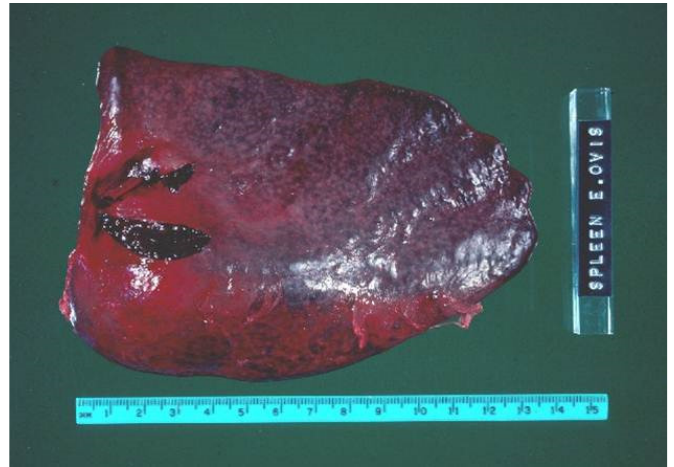
Figure 1. Historical image of splenomegaly in a lamb diagnosed with Epyrethrozoan ovis, now Myco- plasma ovis . Mycoplasma ovis